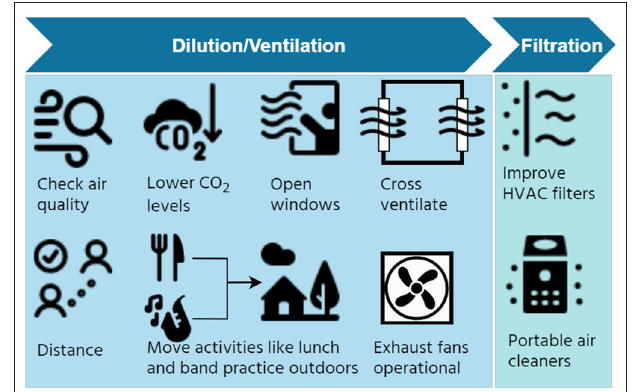
FIGURE 1 | Clean indoor air: dilution, ventilation, and filtration based